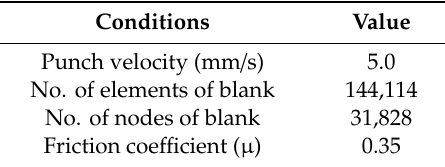
Table 3. FE analysis conditions.